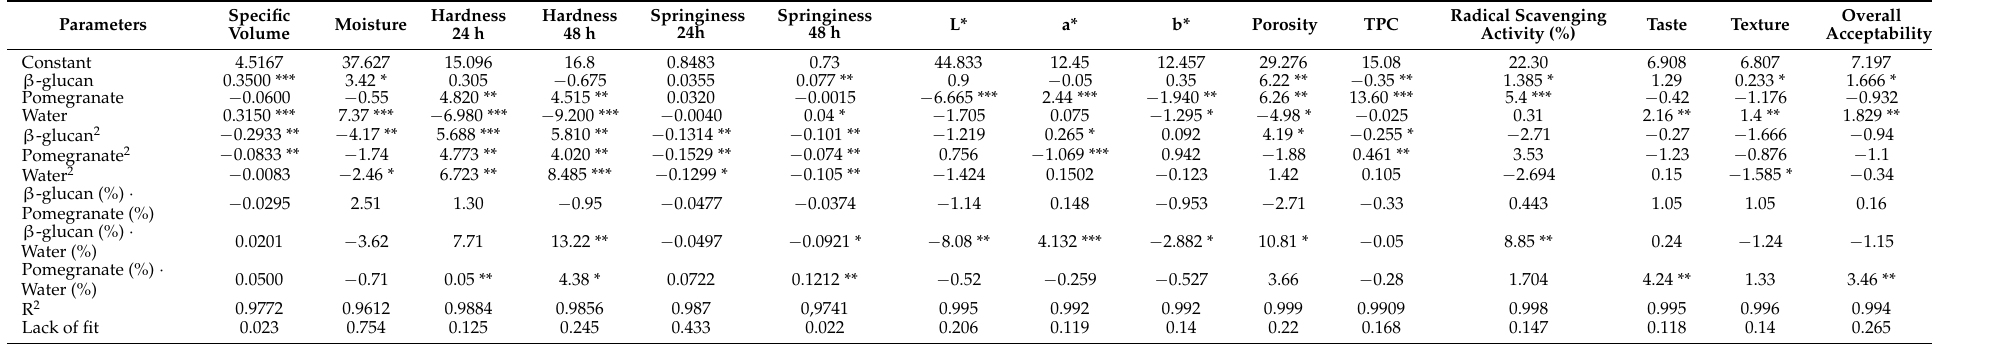
Table 3. Estimated regression coefficients of the fitted second-order polynomial model and their